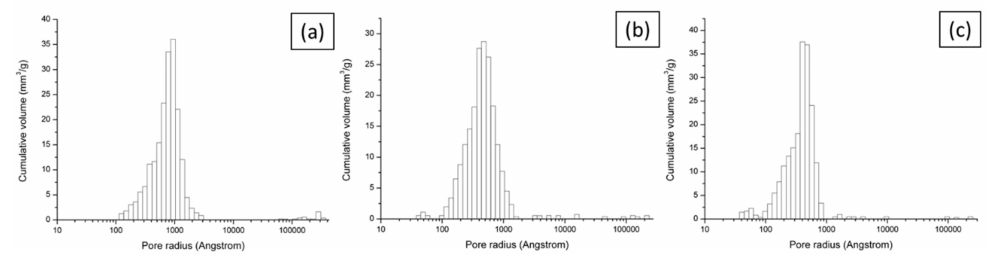
Figure 7. Pore size distribution for brown ( a ), red ( b ) and white ( c ) ceramic samples.